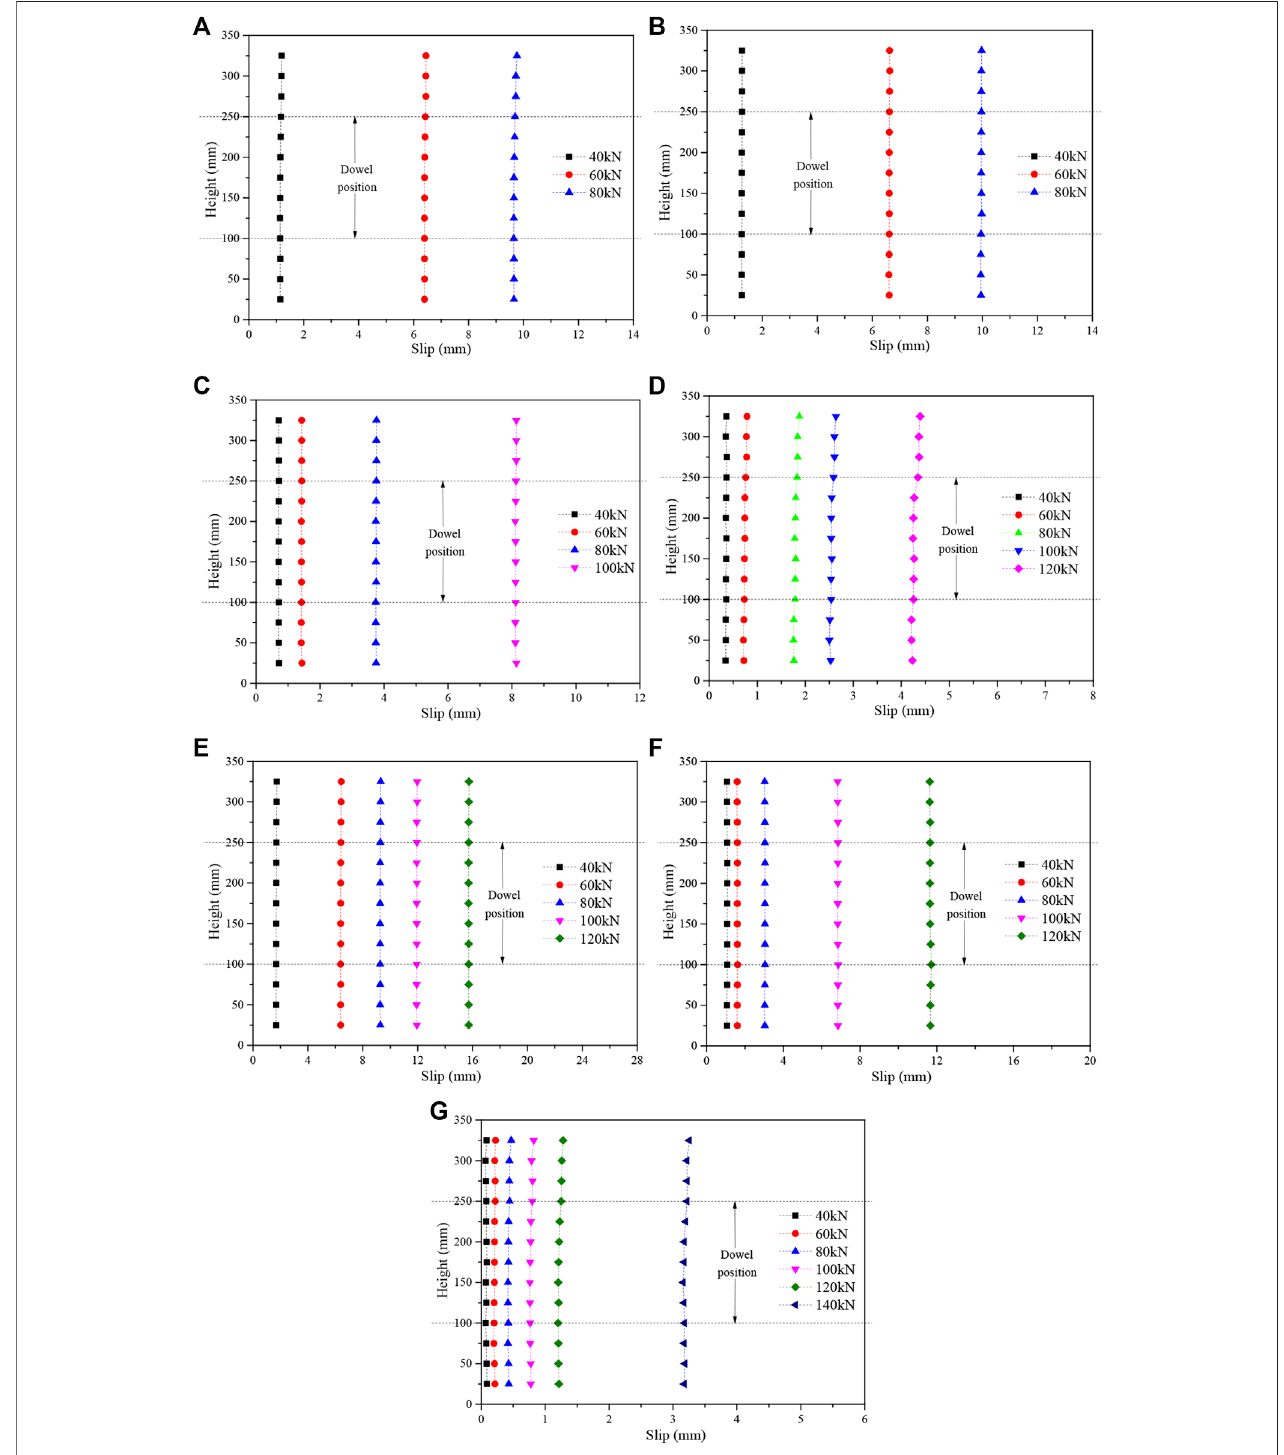
FIGURE15| Thecurvesofslipofwood-concretespecimensalonginterfaceheight. (A) W3008-3left, (B) W3008-3right, (C) W3012-3right, (D) W3016-2right, (E) W5008-3 right, (F) W5012-2 right, (G) W5016-1 right.